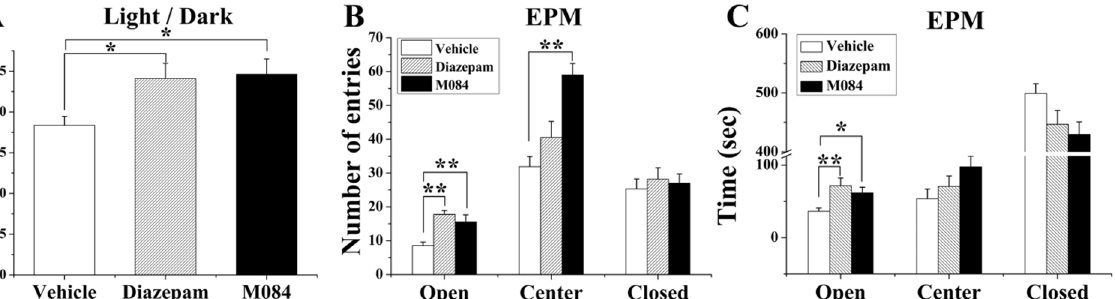
Fig 2. M084 exhibits anxiolytic-like effects in mice. (A) In the light/dark transition test, M084 treatment (10 mg/kg, 2 hrs) resulted in an increase in the number of entries in the light chamber. (B&C) In elevated plus maze (EPM) test, animals treated with M084 had more entries in all areas (B) and spent more time in the open arms and central area and less time in the closed arms (C) as compared to those treated with vehicle. Diazepam, a known antianxiety agent, was used as a positive control (1.5 mg/kg, 2 hrs). Results are shown as mean ± SEM. N = 12/group, * p < 0.05, ** p < 0.01.